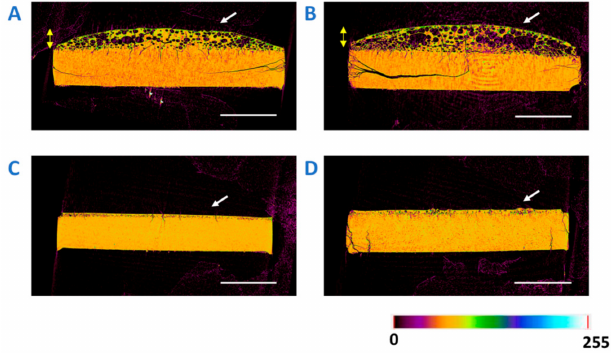
Figure 10. X-ray microcomputed tomography cross-sectional images for the 30% DL ASD tablets with 0% TPGS ( A ), 2% TPGS ( B ), 5% TPGS ( C ), and 10% TPGS ( D ) after 10 min of dissolution. Scale bar (in white) is 2 mm. Arrow (in white) on the images is pointing toward the dissolution front of the tablet. The color bar represents the range of density measurement from lowest (0) to highest